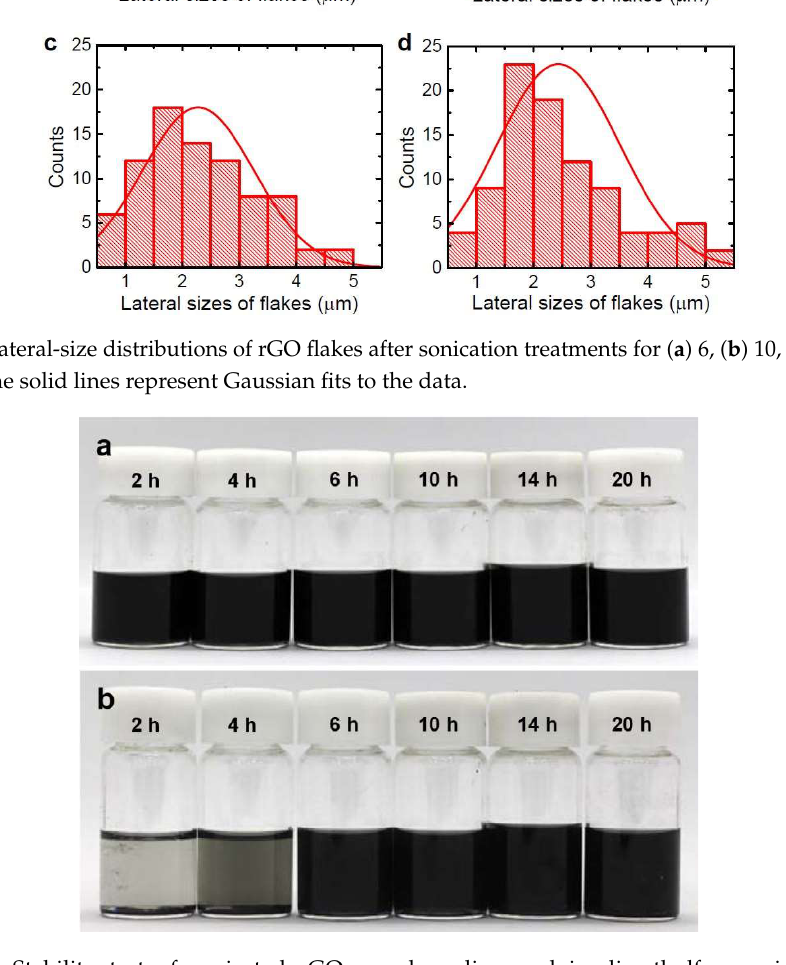
Figure 4. Stability test of sonicated rGO powders dispersed in dimethylformamide (DMF). ( a ) As-